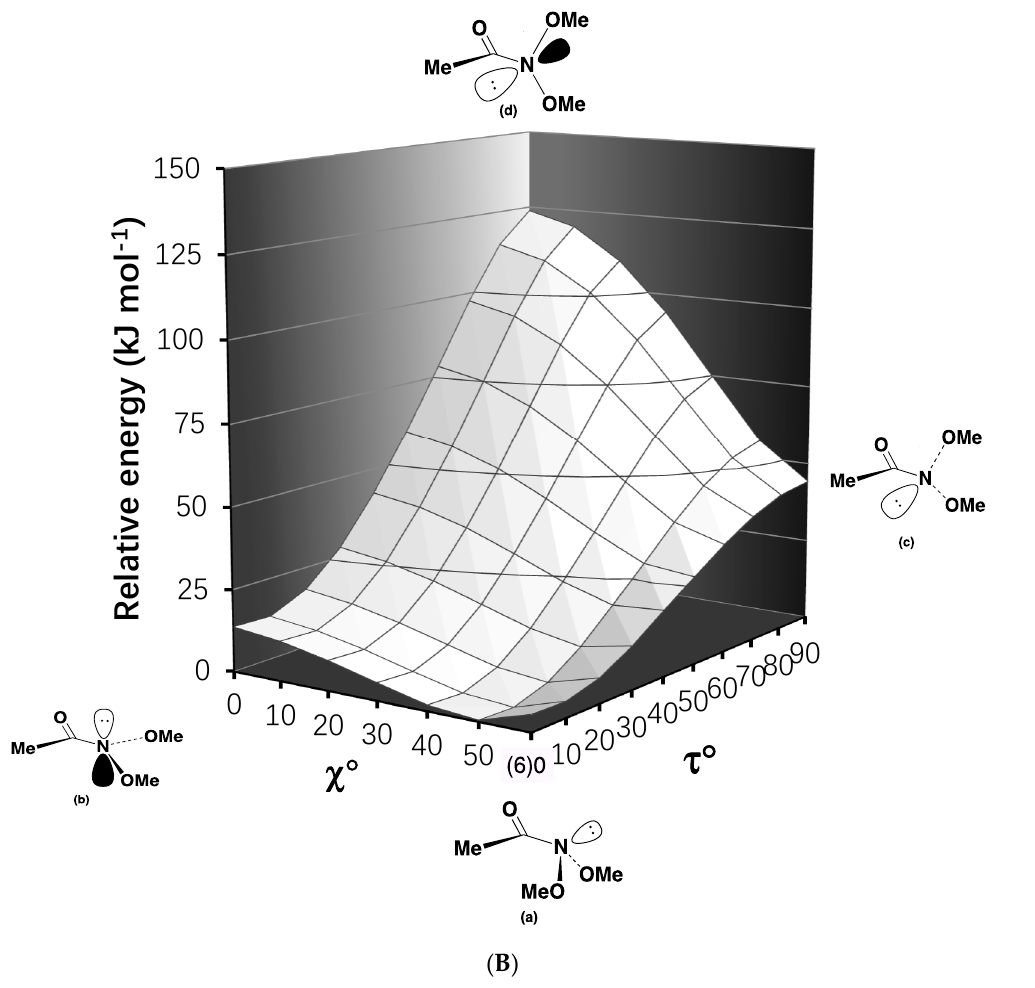
Figure 5. B3LYP/6-31G(d) energy surfaces for deformation of ( A ) N -methoxy- N -methylacetamide 3b and ( B ) N , N -dimethoxyacetamide 4b . ( a ) Untwisted system with sp 3 hybridised nitrogen; ( b ) planar untwisted structure; ( c ) 90° rotated structure with sp 3 hybridisation at nitrogen; and ( d ) the fully twisted moiety with sp 2 hybridised nitrogen.